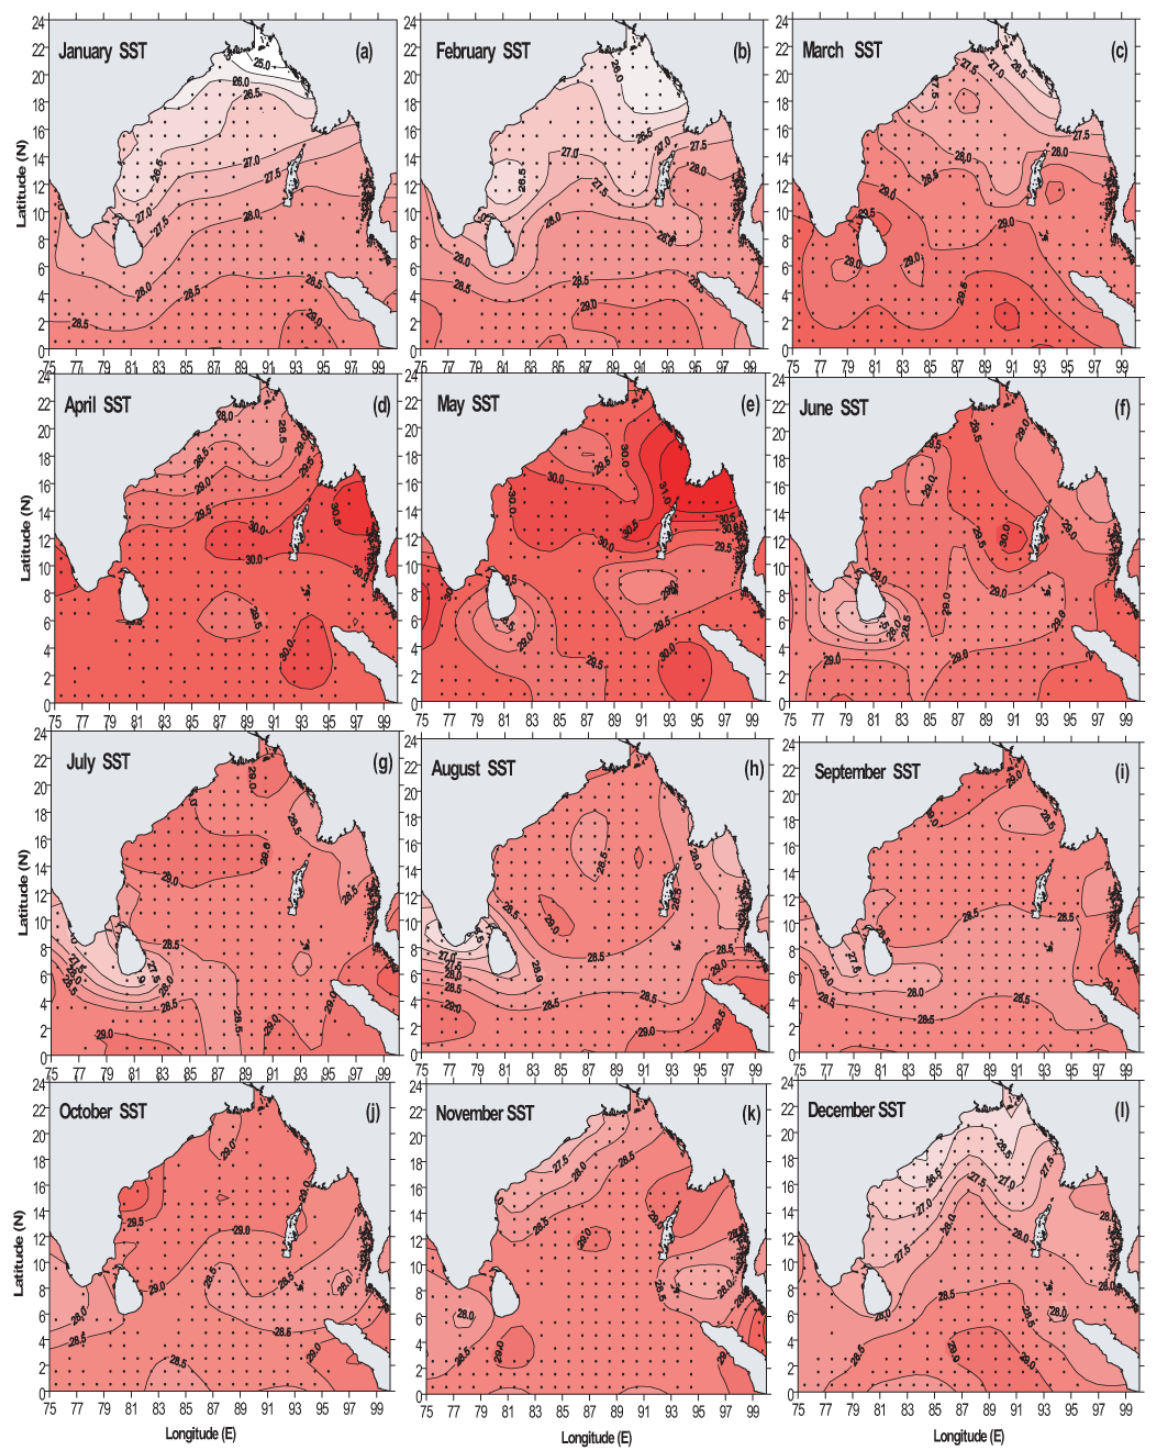
Figure A2. Monthly mean climatology of sea surface temperature (SST, ◦ C) from January to